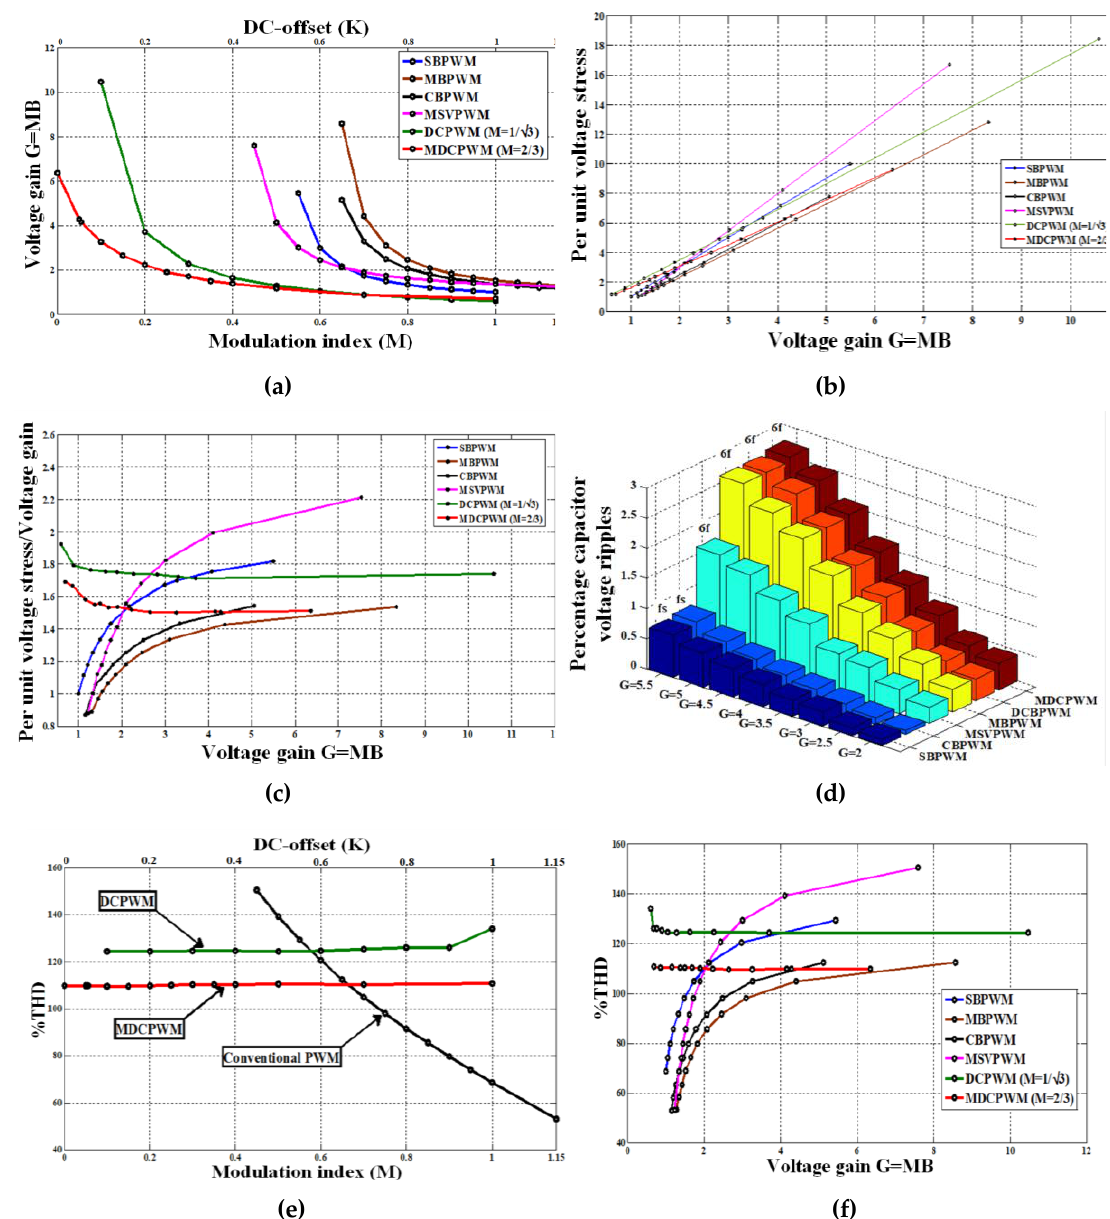
Figure 9. Simulation-based comparison between the discussed PWM control techniques: ( a ) Voltage gain versus modulation index (M) , DC-offset (K) for conventional and ZSI-DCPWM techniques respectively, ( b ) per-unit voltage stress versus voltage gain, ( c ) per unit voltage stresses / voltage gain versus voltage gain, ( d ) percentage capacitor voltage ripples for the discussed and the proposed ZSI PWM techniques at different gain points ( e )%THD versus control variable (M),(K) and ( f ) %THD versus voltage gain.